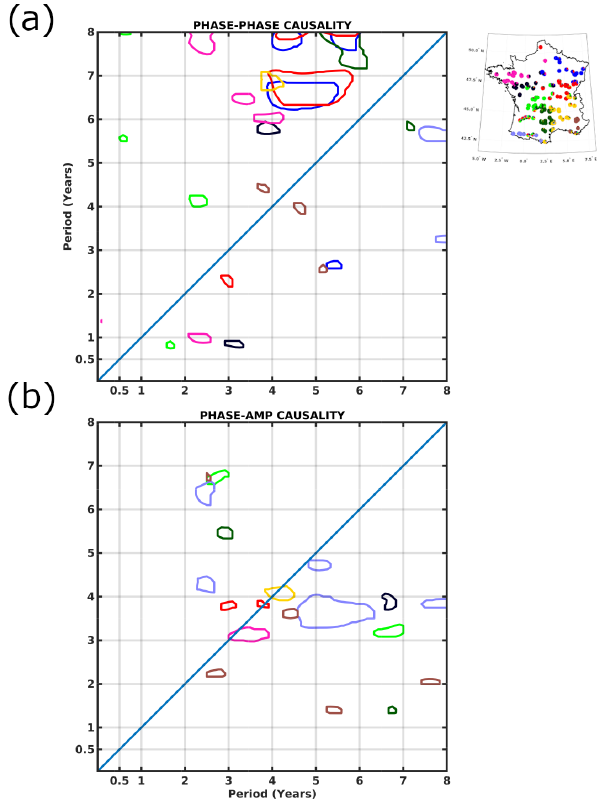
Figure 9. Temperature cross-scale interactions (95% significance level). The driving timescale is on the horizontal axis and the driven on the vertical axis (i.e., the timescale x phase has a causal relation- ship with the phase/amplitude of the driven timescale y ). Lower (up- per) half of the graph, below (above) the diagonal, shows timescales acting on smaller (larger) timescales. (a) Phase–phase causality. (b) Phase–amplitude